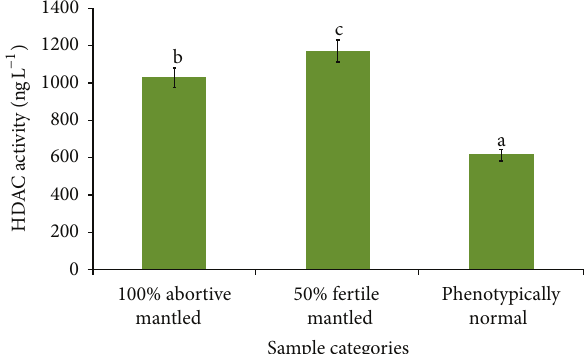
Figure8:AverageHDACactivitylevelsofleafsamples. Meanvalues with different letters are significantly different at 𝑃 < 0.05